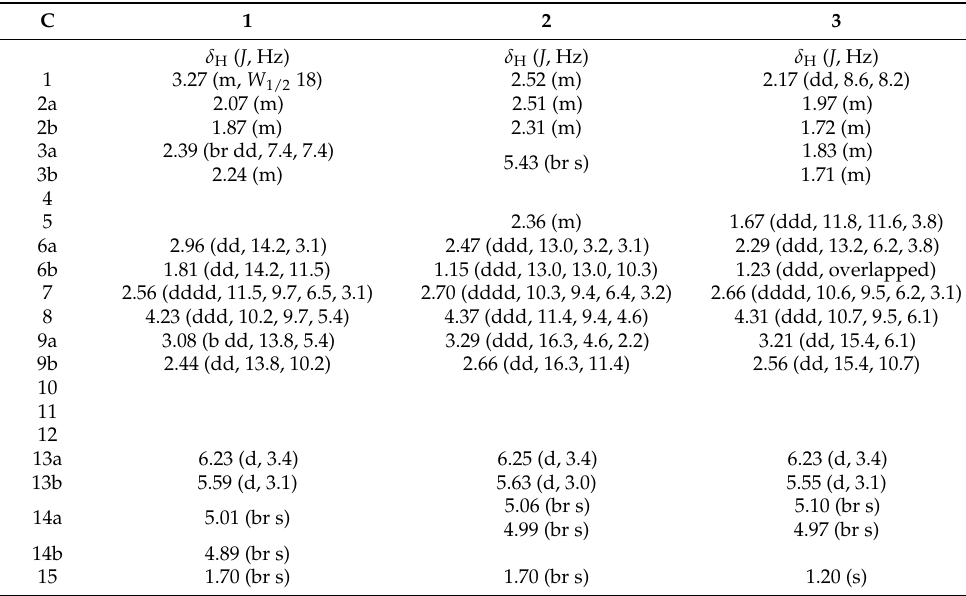
Table 1. 1 H NMR data a–c in CDCl 3 for centaurolide A ( 1 ) and B ( 2 ), and inuviscolide ( 3 ) d